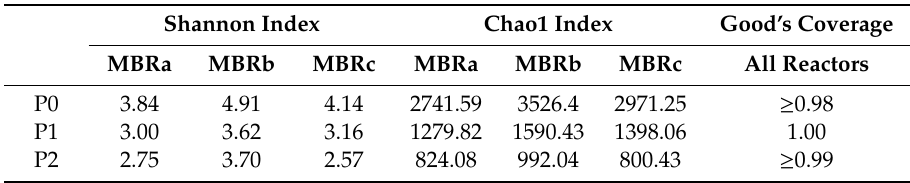
Table 1. The Shannon and Chao1 index of activated sludge samples in three stages in MBRa, MBRb, and